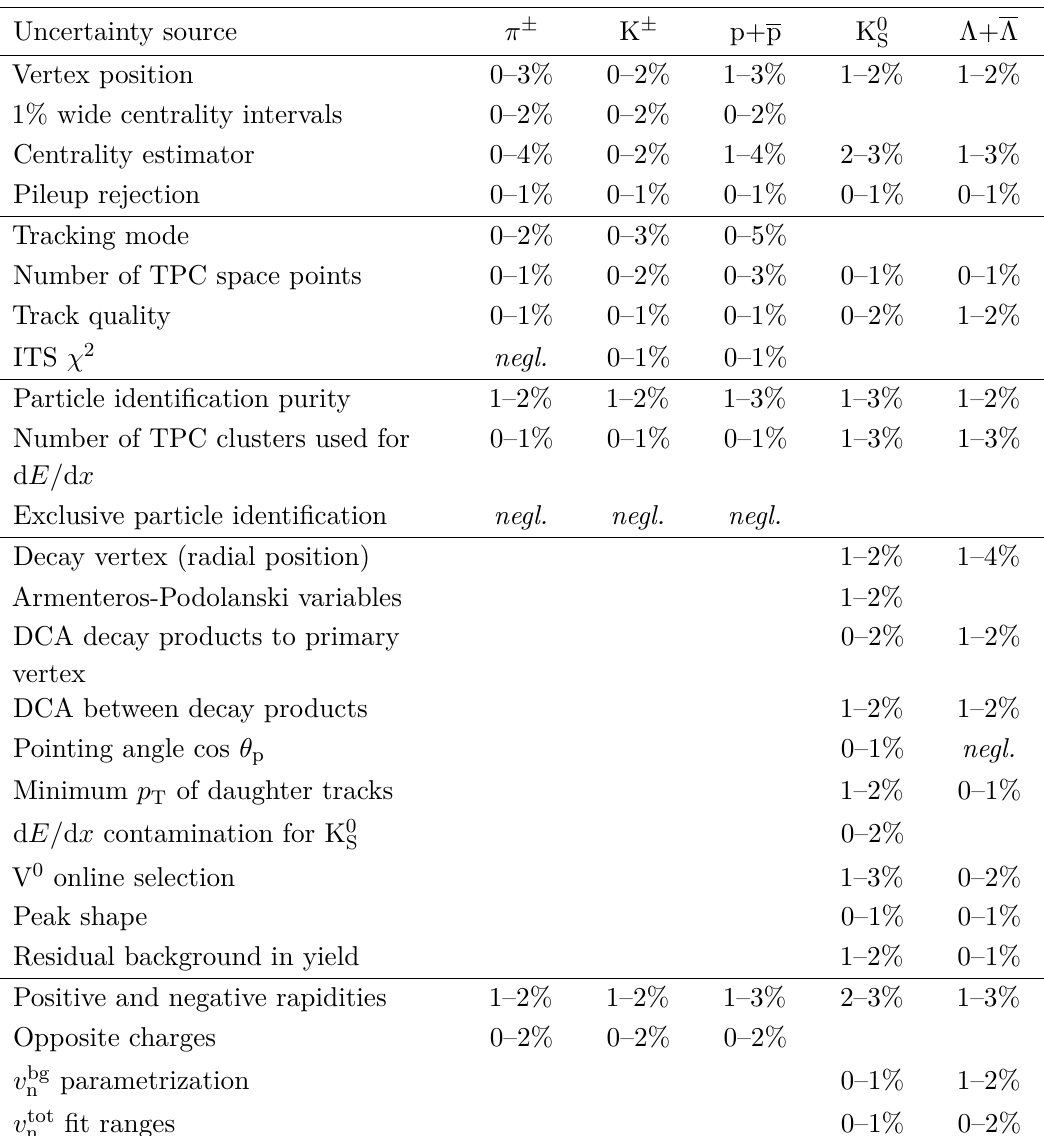
Table 1. Summary of systematic uncertainties for the v 2 of π ± , K ± , p+ p , K 0 tainties are given as intervals between the minimum and maximum values for all p T and centrality ranges. Empty fields indicate that a given check does not apply, while the field marked negl. for negligible implies that the tested uncertainty cannot be resolved within the statistical